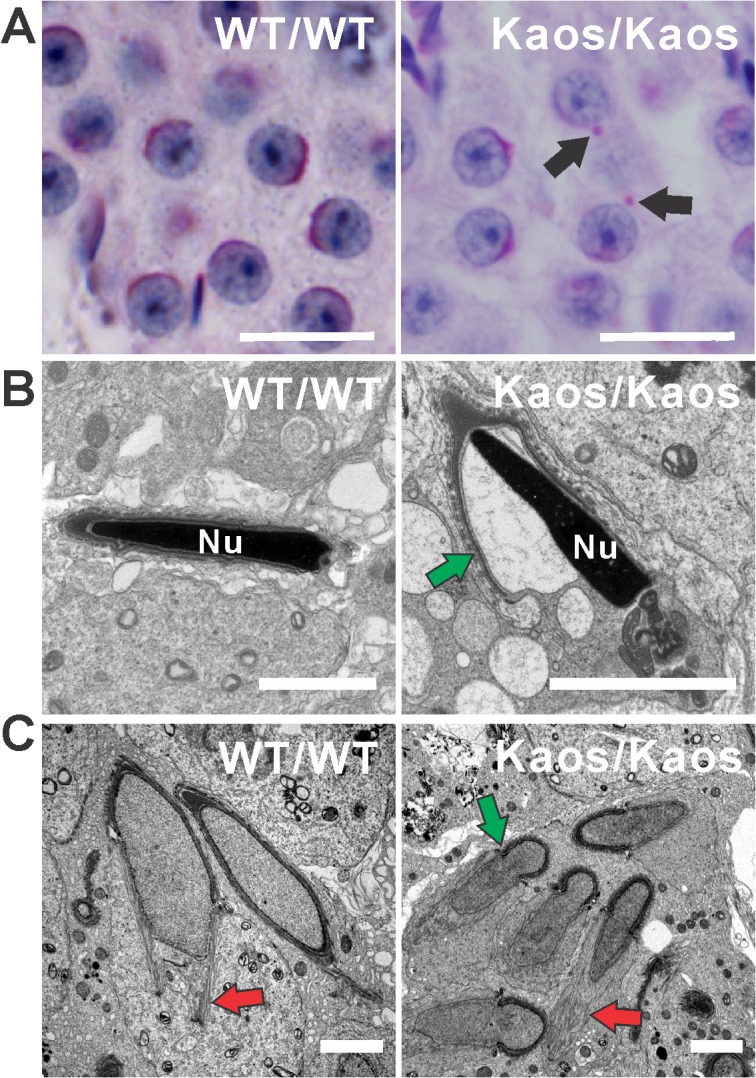
Acrosome and manchette defects in Lrguk
Kaos/Kaos mice.
(A) PAS stained testis sections from Lrguk
WT/WT and Lrguk
Kaos/Kaos mice. Arrows indicate mis-localised proacrosomal vesicles. (B) Transmission electron microscopy of elongated spermatid from Lrguk
WT/WT and Lrguk
Kaos/Kaos mice. The green arrow indicates a detached acrosome. Nu = nucleus. Scale bar = 2μm. (C) Transmission electron microscopy showing abnormal manchette structure including a constricted perinuclear ring (green arrow). Red arrows indicate microtubules within the manchette.